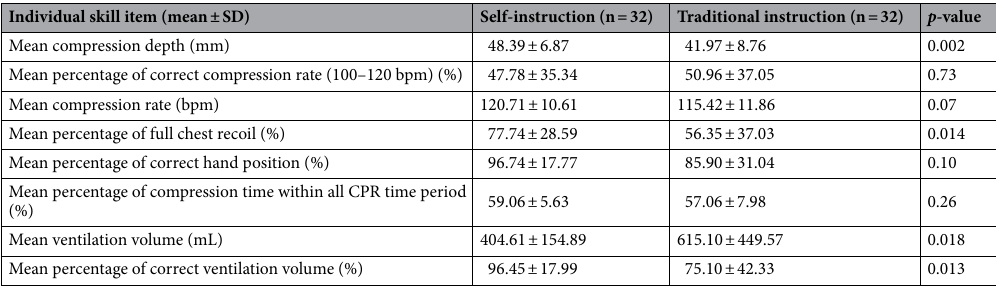
Individual skill item (mean ±